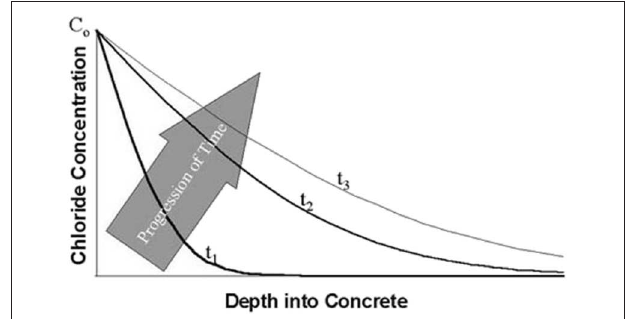
FIGURE 13 | Chloride concentration within concrete over time.